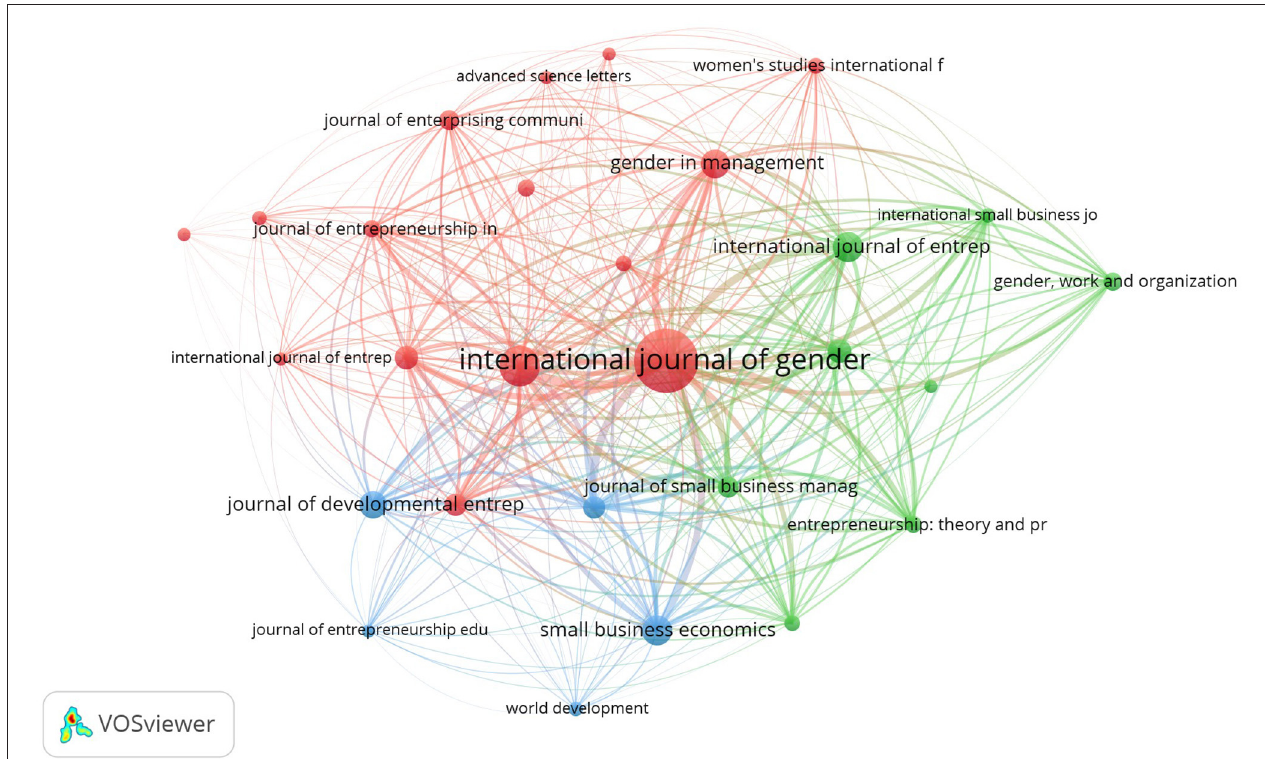
FIGURE 5 | Scientific Journal analysis of the women entrepreneurship